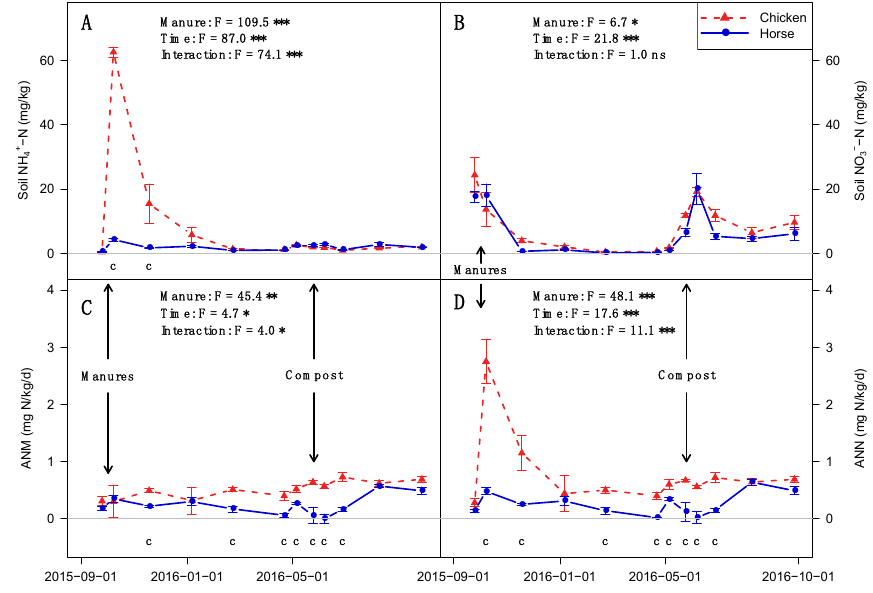
Figure 2. Soil ammonium ( A ; NH 4 + -N), nitrate ( B ; NO 3 − -N), apparent net mineralization ( C ; ANM), and apparent net nitrification ( D ; ANN) during the study (mean ± standard error). Arrows indicate the date of manure (2 Oct. 2015) and municipal compost (25 May 2016) application. Results from ANOVA factors refer to the full model with repeated measures, where *** = p < 0.001, ** = p < 0.01, * = p < 0.05, ns = p > 0.05. Letters along the x-axis indicate that chicken (“c”) was significantly greater ( p < 0.05) than the other manure type in one-way ANOVAs computed on individual dates when the manure x time interaction was significant.